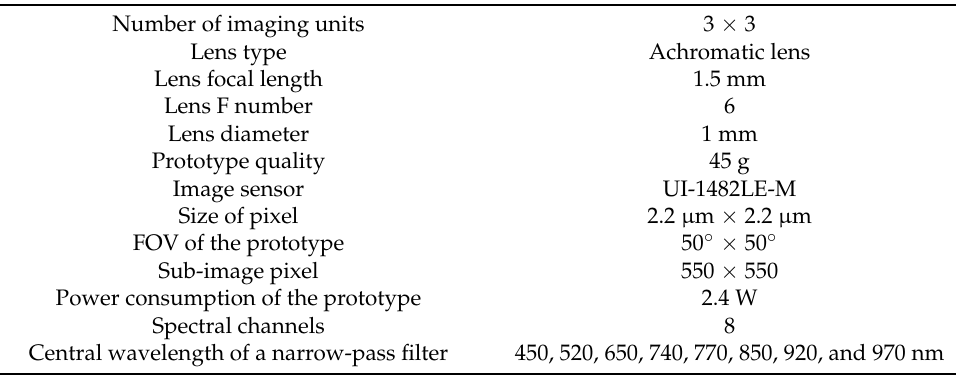
Table 3. Specifications of multispectral